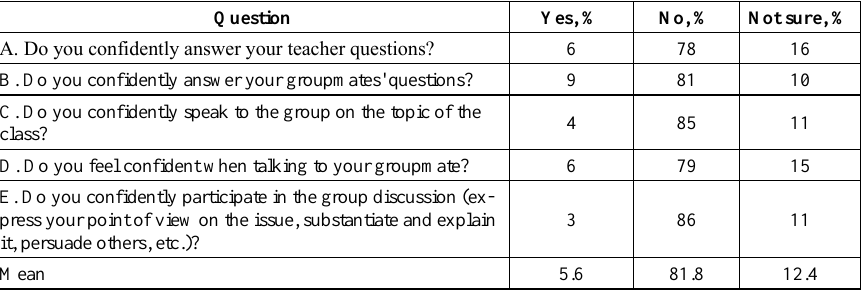
Table 4. Level of foreign language communication skills